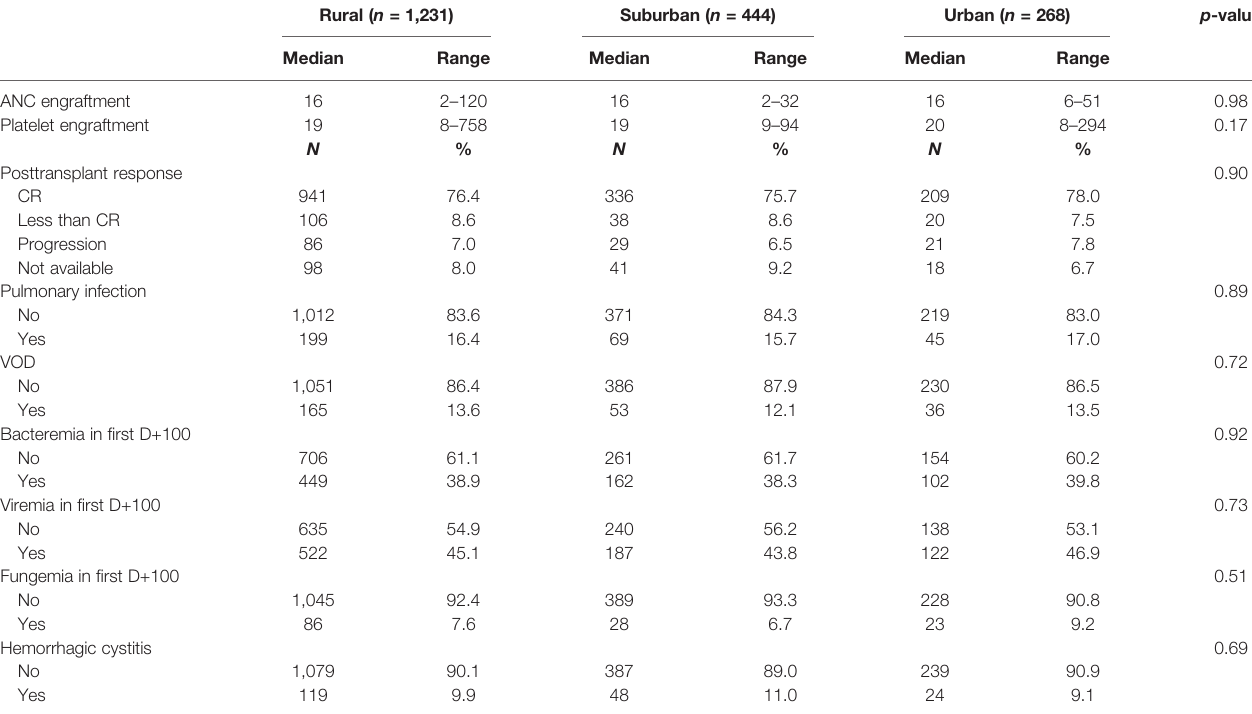
TABLE 4 | Transplant outcomes by